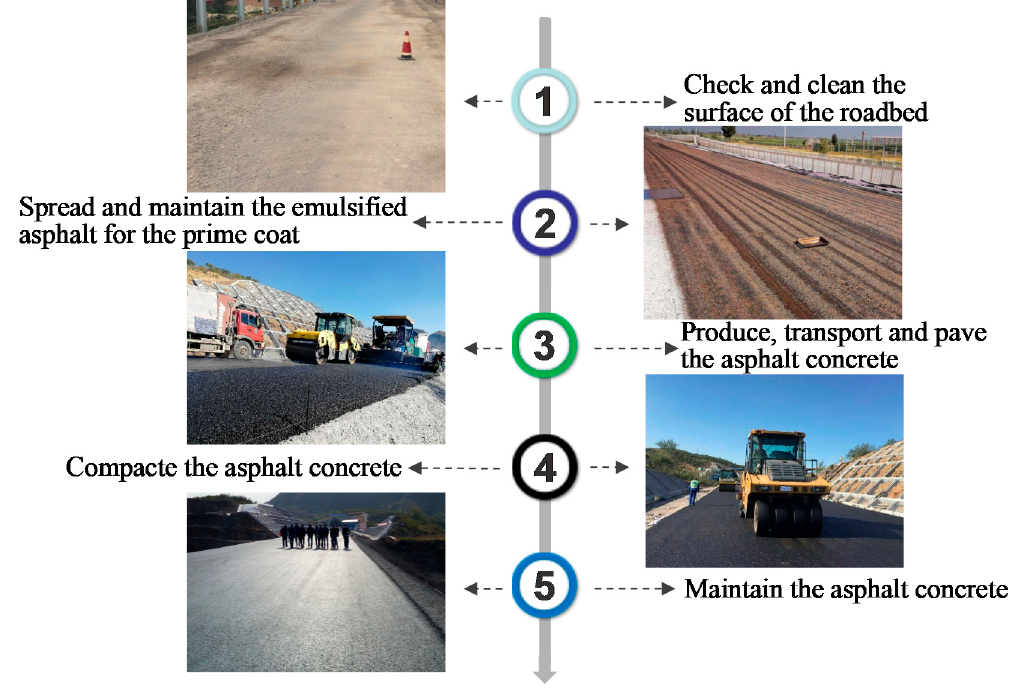
Figure 4. Construction process of the asphalt concrete in railway.